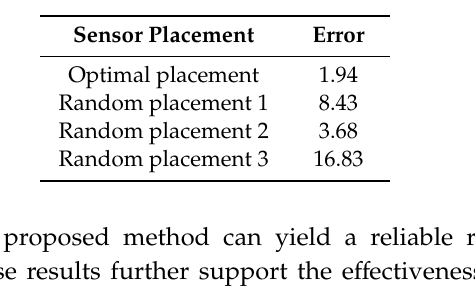
Table 8. Reconstruction errors (%) for 85